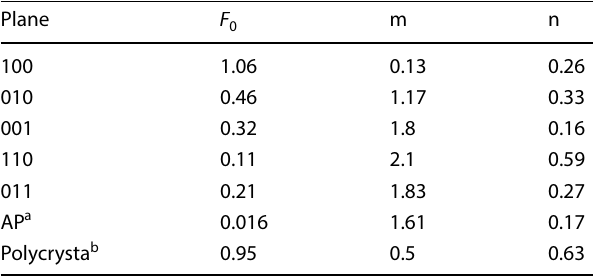
Table 3 Anisotropic viscoplastic parameters